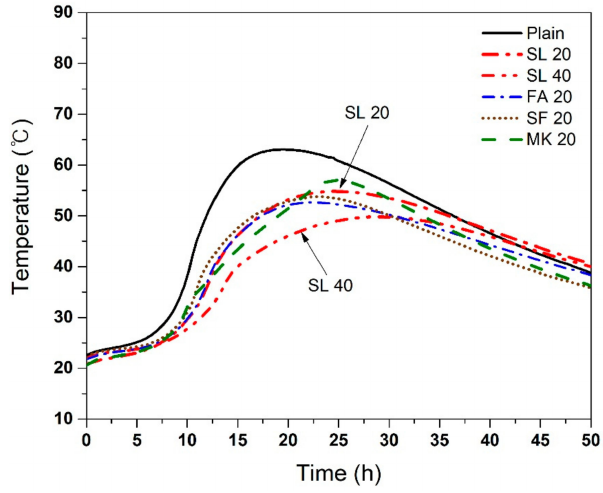
Figure 4. Semi-adiabatic temperature rise of the concrete with various SCMs. The difference in the maximum temperature of repeat specimens was generally <5% when tested in laboratory with constant